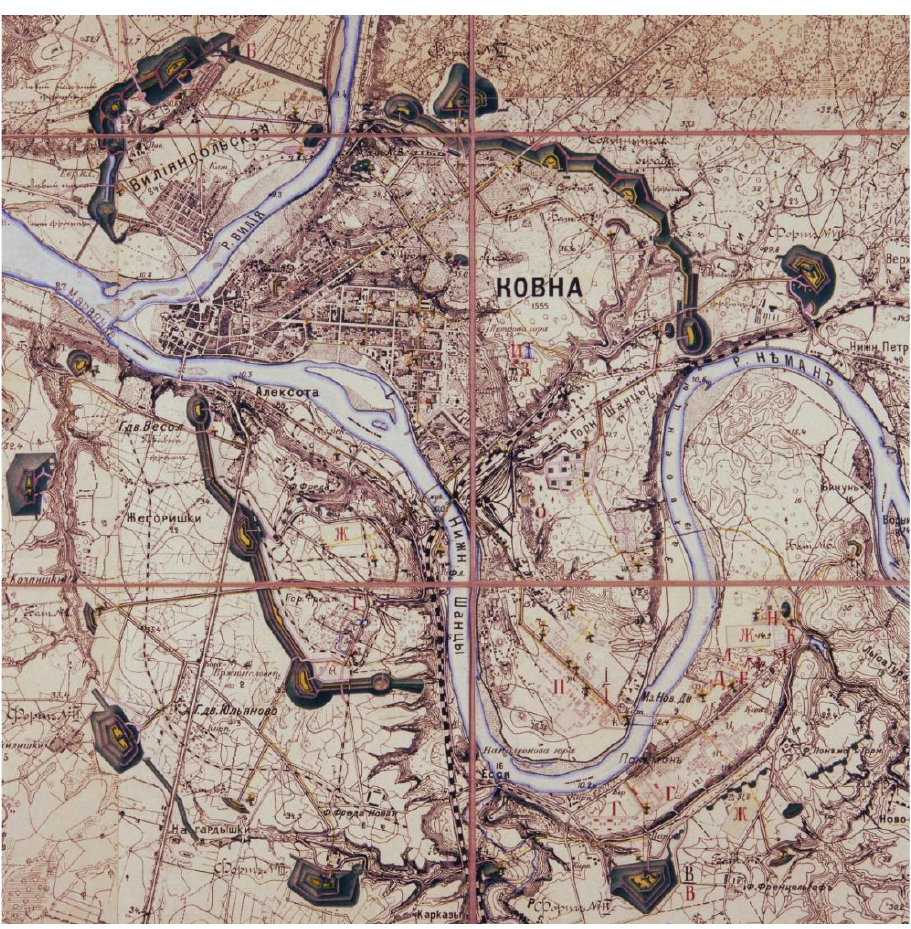
Figure 10. The scheme of Kaunas Forts (Lithuania) and its trail in 19th century. Available online: https://tinyurl.com/2n8uaf6k (accessed on 24 January 2022).